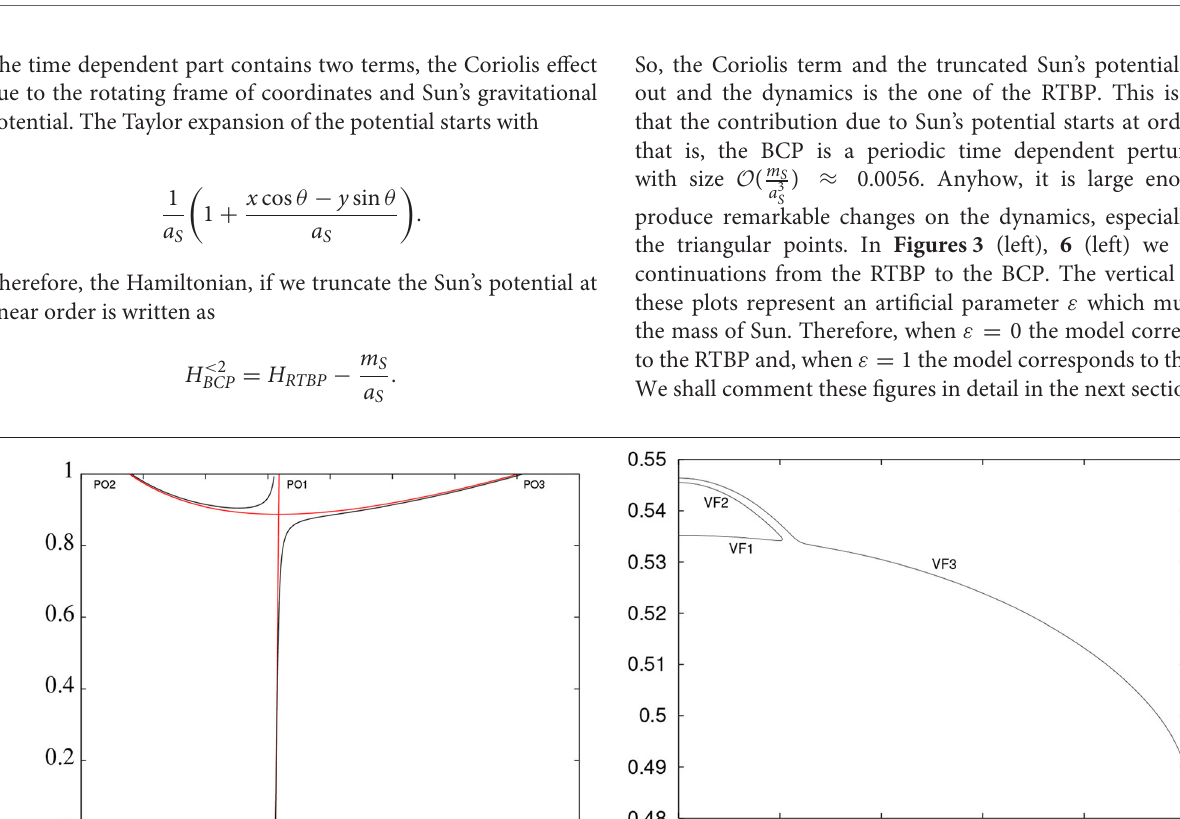
Frontiers in Applied Mathematics and Statistics |